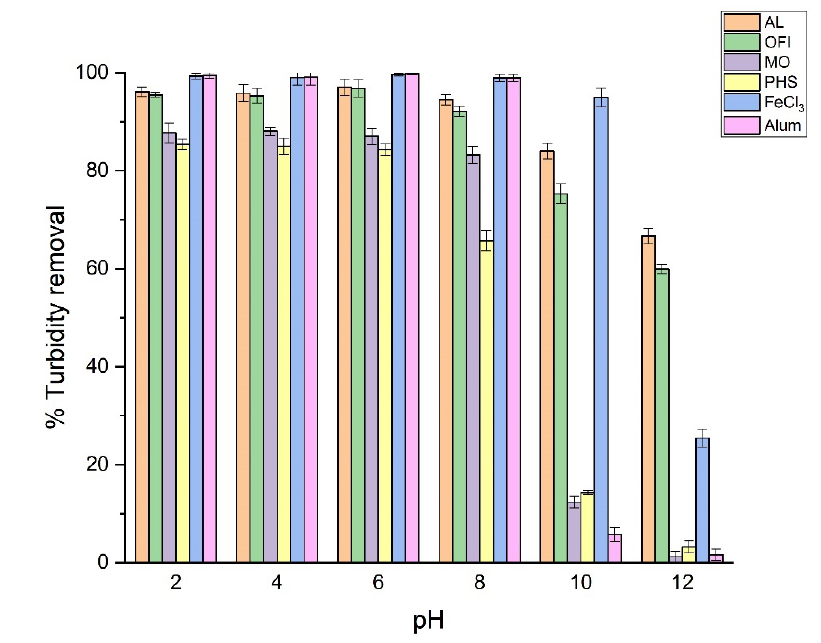
Figure 4. Effect of initial pH on turbidity removal.